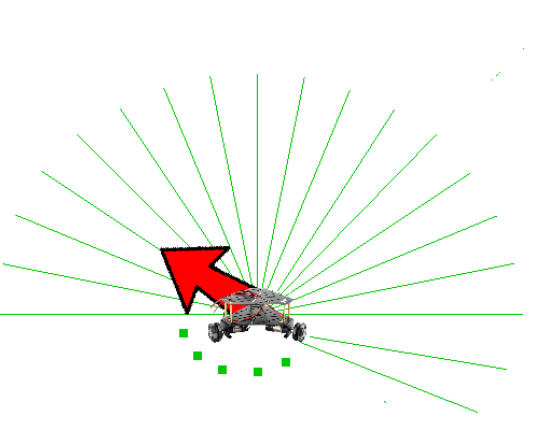
Figure 2. A visual example of the detected local environmental information of the mobile robot. Note that the green lines in the figure are the laser beams, which will reflect after touching an obstacle. These laser beams can detect the obstacles within a maximum distance of d max ; hence, there exists 0 (cid:54) d i ( t ) (cid:54) d max . Furthermore, a location sensor is incorporated to calculate the bias of the heading direction, which is the red arrow in the figure, and is denoted as φ ( t ) satisfying − 180 ◦ < φ ( t ) (cid:54) 180 ◦